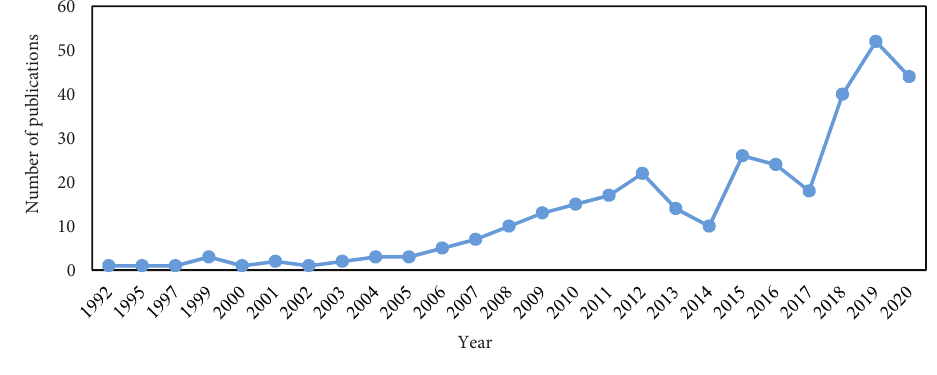
Figure 2. Annual publication from 1992 to